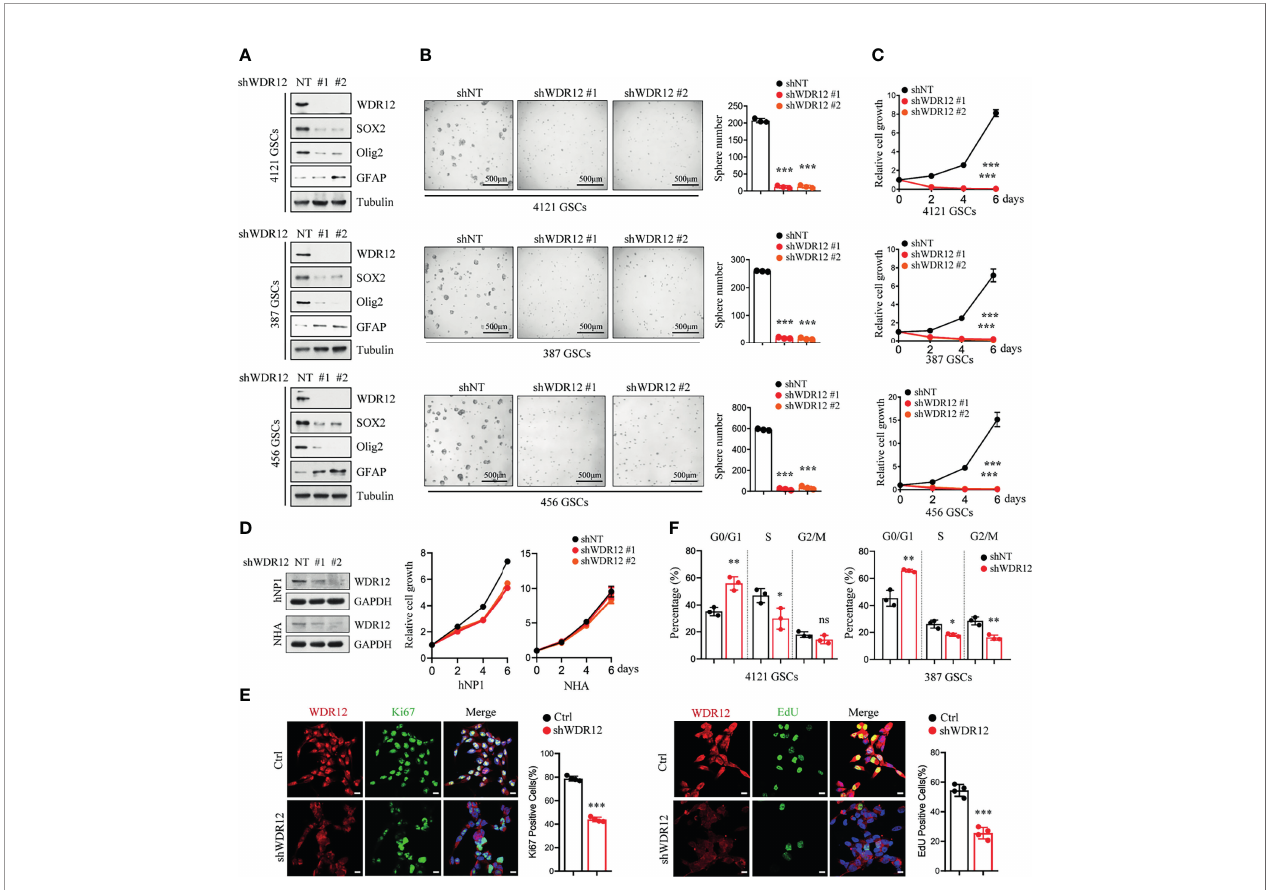
FIGURE 2 | Depletion of WDR12 inhibits GSC cell proliferation. (A) GSCs (4121, 387, and 456) were transduced with two different shWDR12 sequences for 24 hours. IB showing the levels of indicated proteins in Ctrl and WDR12 knocked down GSCs. (B) Quanti fi cations of tumor sphere numbers (2,000 cells/well) formed by Ctrl or WDR12 knocked down for 5 days in GSCs (right). Representative images of tumor spheres are shown (left). (C) GSCs (4121, 387 and 456) transduced with shWDR12 resulted in a decrease in cell viability, as measured by cell titer assay. (D) Knockdown of WDR12 had limited effects on cell growth of hNP1 and NHA, as measured by cell viability assay. IB showing the ef fi ciency of WDR12 knockdown (left). (E) Knockdown of WDR12 inhibited GSC proliferation. Ki67 staining (left) and EdU incorporation assay (right) were performed in 4121 GSCs transduced with shNT or shWDR12 for 24 hours. Representative images are shown (left). The percentages of Ki67+ and EdU+ cells were quanti fi ed (right, 4 random microscope fi elds). Scale bars, 10 m m. (F) Cell cycle analysis were performed by fl ow cytometry in 4121 and 387 GSCs transduced with shNT or shWDR12 for 24 hours. Data are represented as mean ± SD. *p < 0.05, **p < 0.01, ***p < 0.001, as assayed by Unpaired Student ’ s t-test or Welch ’ s t test. ns, no